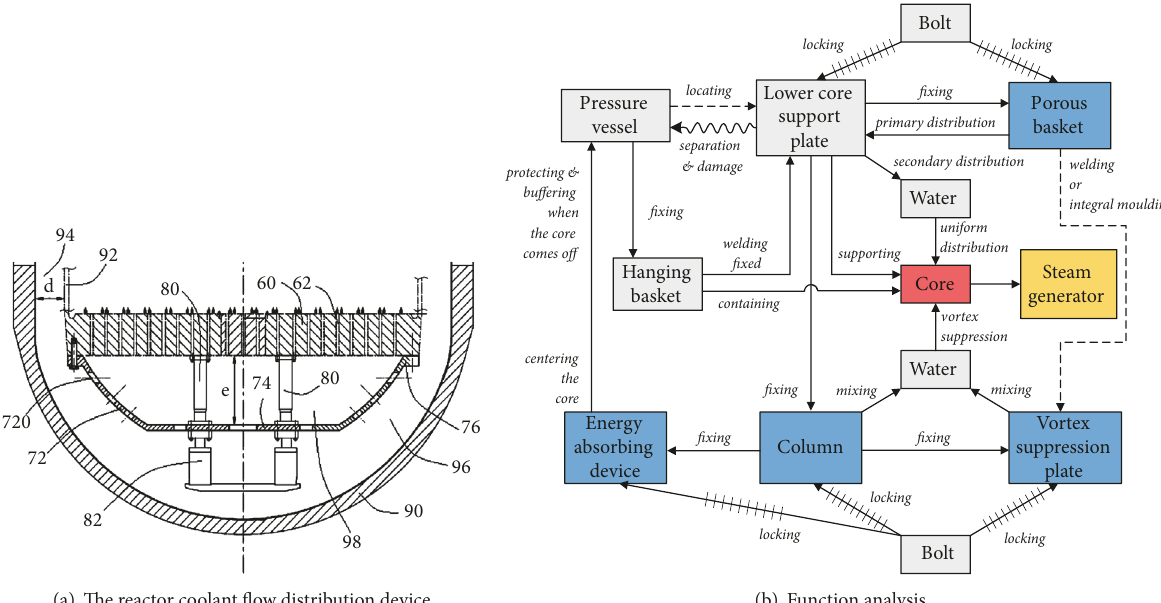
Figure 2: Functional analysis of the coolant flow distribution system. (a) The reactor coolant flow distribution device [23]. (b) Function